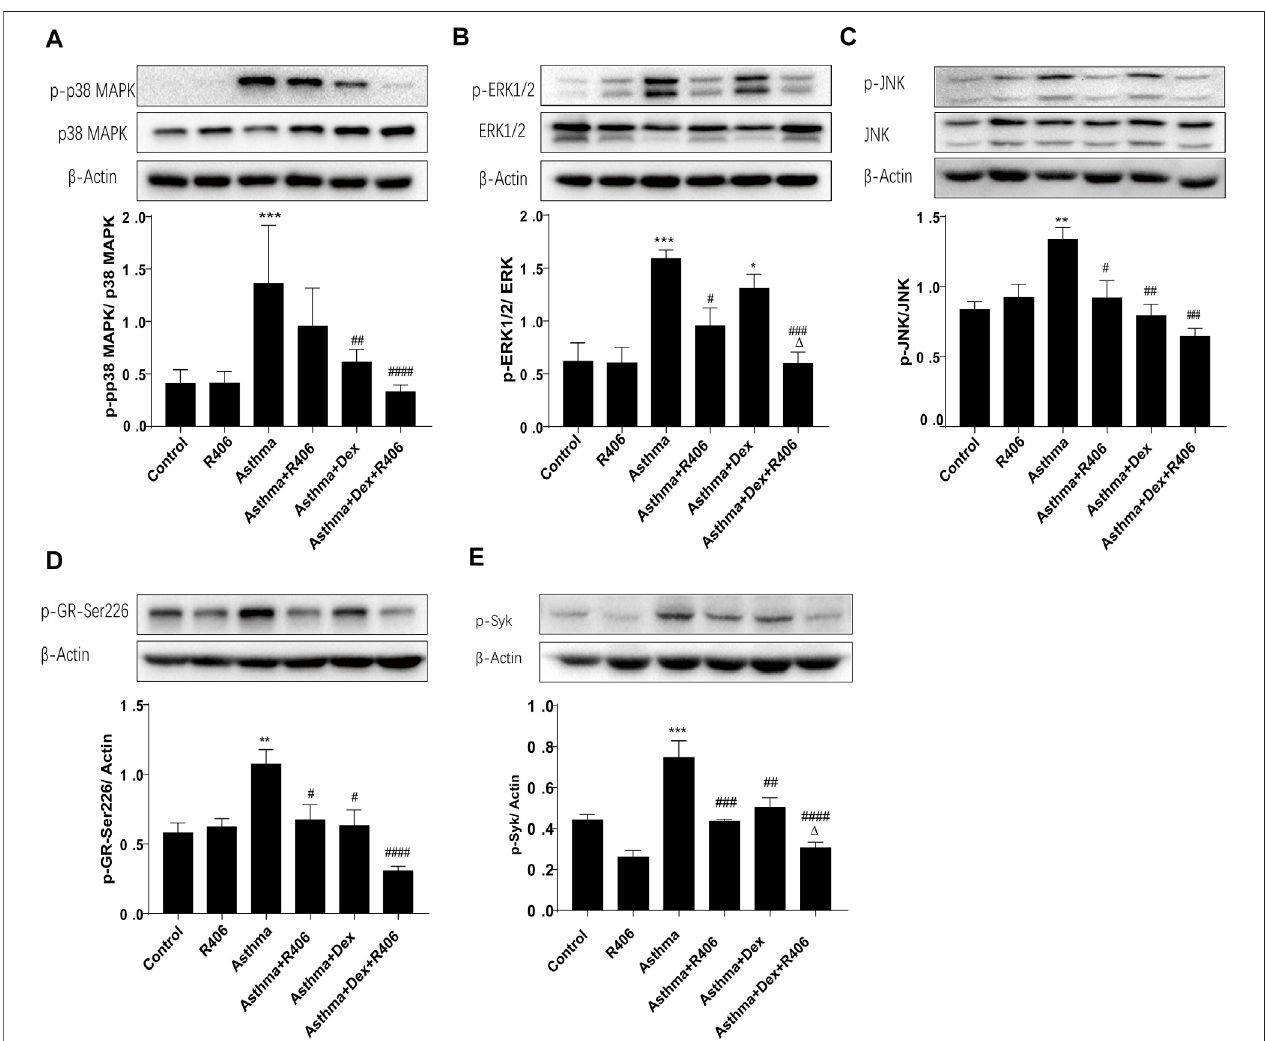
FIGURE3| TheSykinhibitorR406enhancesDex-mediatedinhibitionofMAPKandSykphosphorylationinanasthmaticmousemodel.Twenty-fourhoursafterthe lastchallenge,thephosphorylationofp38MAPK (A) ,ERK1/2 (B) ,JNK (C) ,GR-Ser226 (D) andSyk (E) wasquanti fi edintherightlungsbyWesternblotting. n =5/group, * p < 0.05, ** p < 0.01, *** p < 0.001,compared withthecontrolgroup; # p < 0.05, ## p < 0.01, ### p < 0.001, #### p < 0.0001,comparedwiththeasthmamodelgroup. △ p < 0.05, compared with the asthma model + Dex treatment